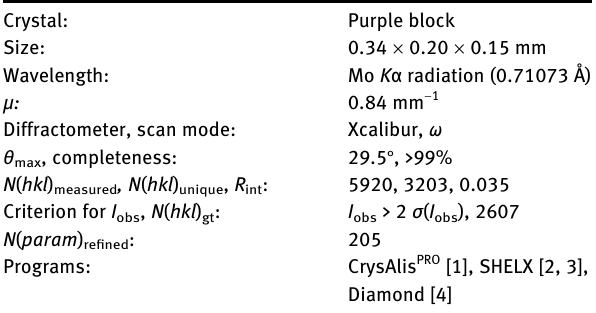
Table  : Data collection and